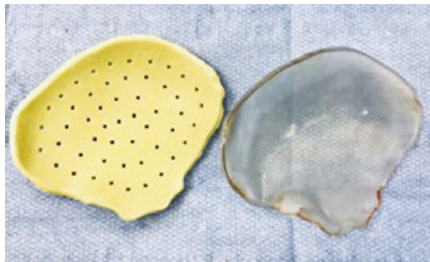
Figure 6: (Left) Ready-to-implant sterile PMMA implant after removal from the silicone mold. (Right) Biocompatible and ster- ilized 3D-printed template (Med610) used to reconstruct the pa- tient’s bone defect; reprinted with permission by Sch¨on et al.